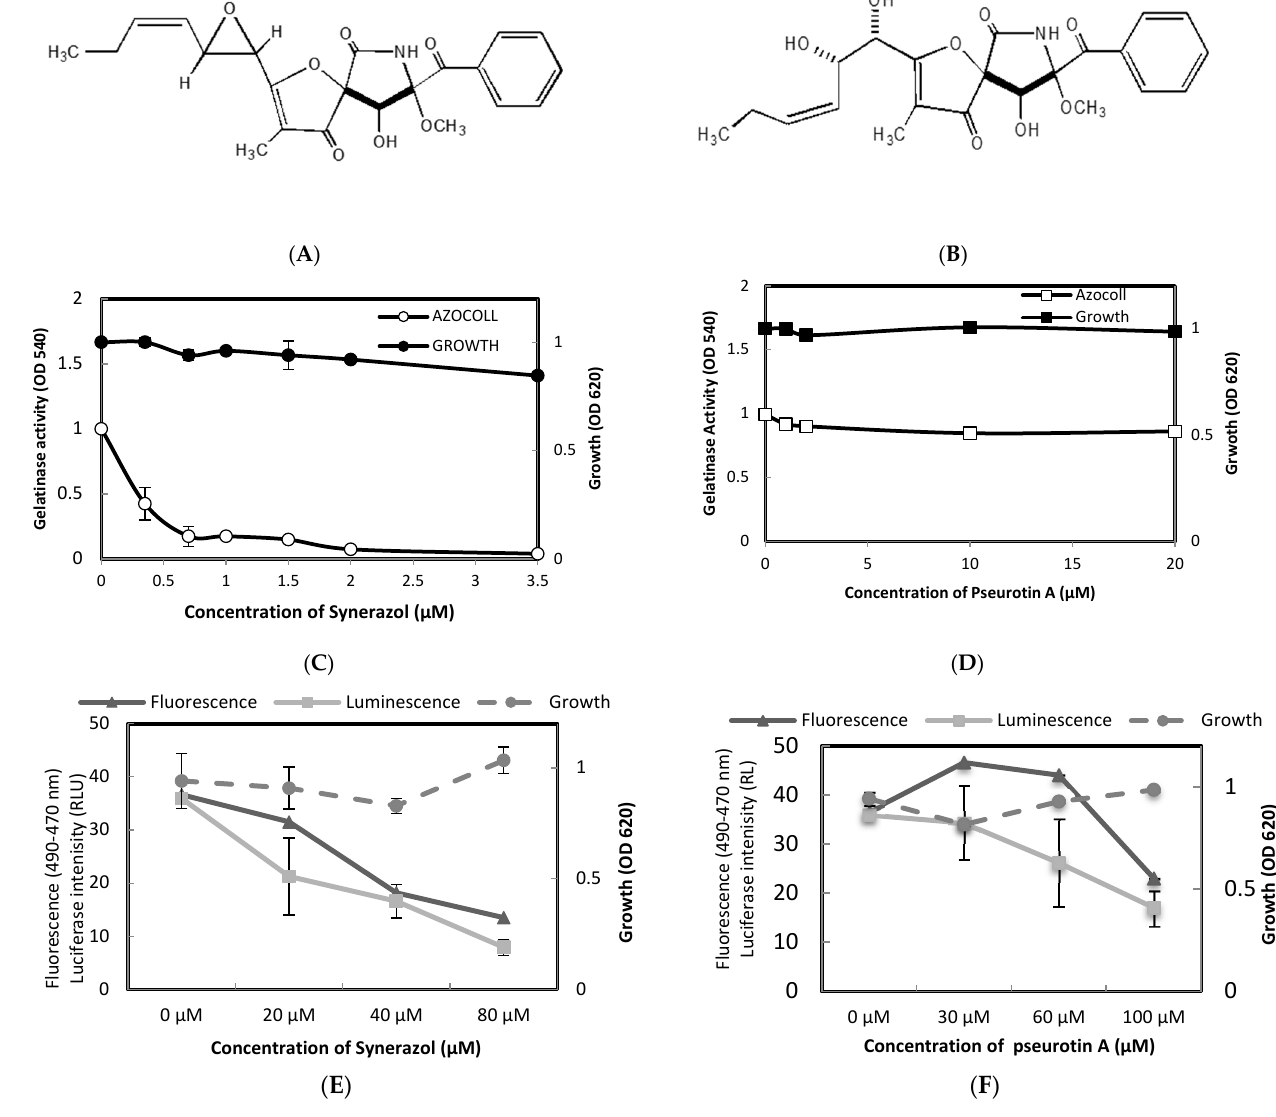
Figure 1. Compounds targeting agr / fsr QS systems. Structures of Synerazol ( A ) and Pseurotin A ( B ). ( C , D ) Effect of various concentrations of Synerazol and Pseurotin A on the cell growth and gelatinase production of E. faecalis . ( E , F ) Effect of Synerazol or Pseurotin A on agr expression in S. aureus 8325-4 (pSB2035).